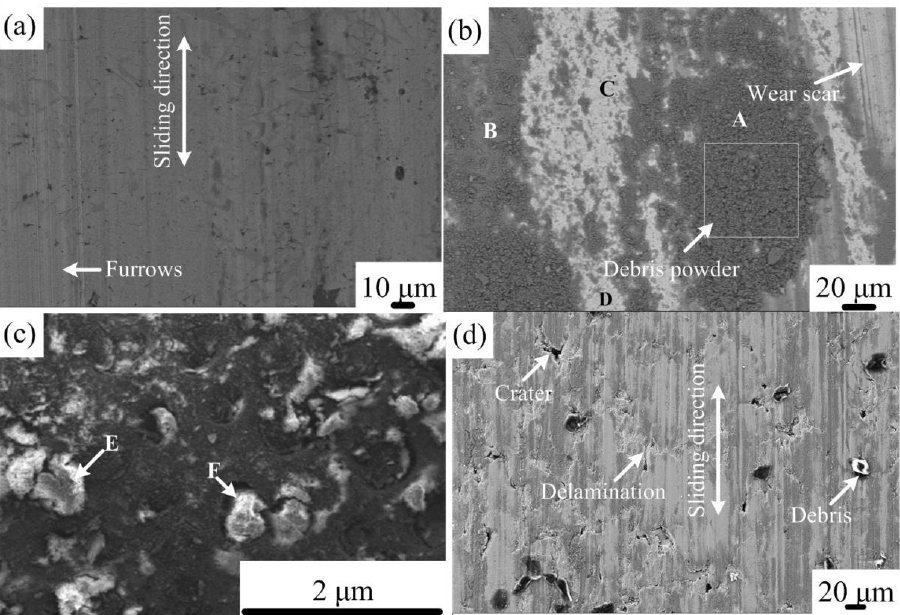
Figure 16. Worn surface morphology of coating: ( a ) 625 m, ( b ) 2500 m, ( c ) magnified wear debris in ( b ), and ( d ) wear surface of HT 300 in the sliding displacement of 2500 m. Table 5. EDS results of the worn surface of Fe-based alloy coating (in wt.%).